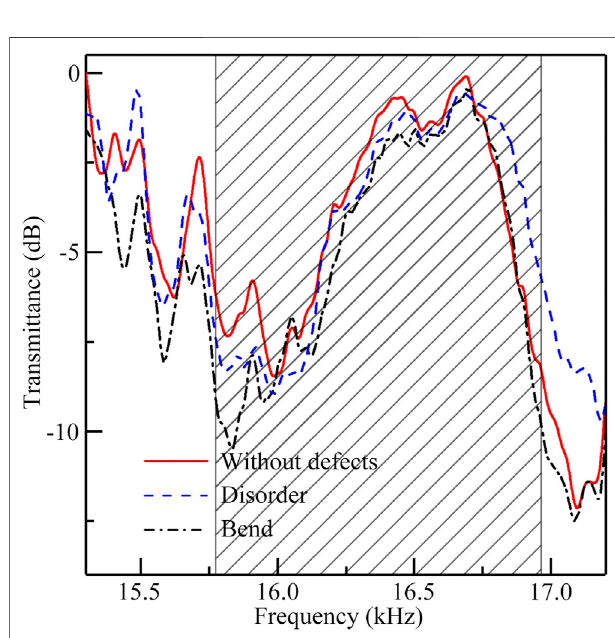
FIGURE 6 | Measured transmittance spectra of the ATIs with and without defects. Black shaded region represents the overlapped bulk band